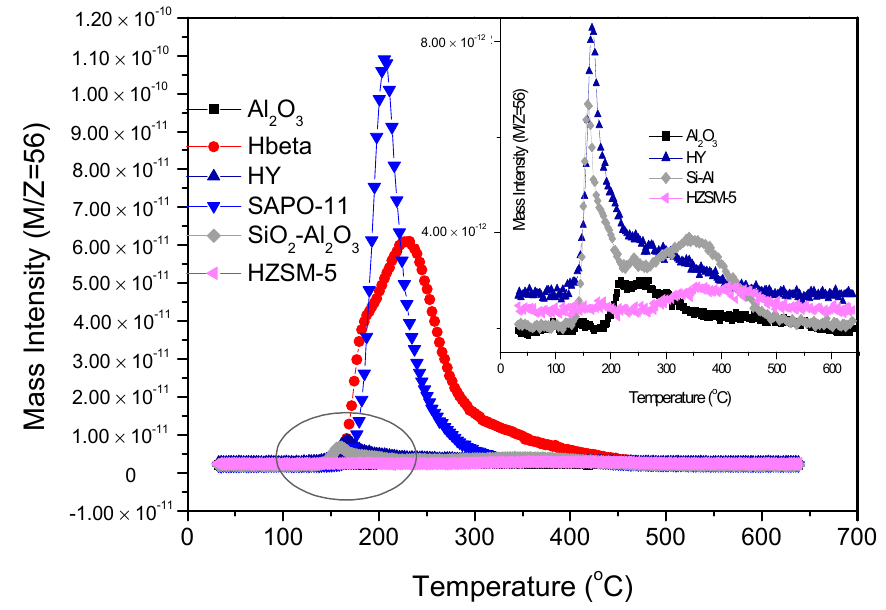
Figure 5. Acrolein in the TPSR of zeolites and oxides.